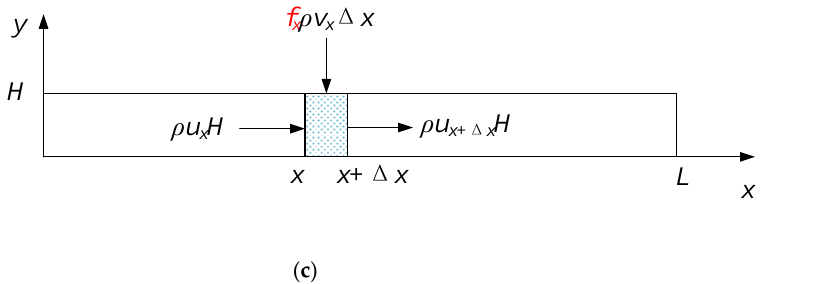
Figure 2. Schematic diagram of a single channel. ( a ) 3-D diagram; ( b ) Diagram for basic outflow model; ( c ) Diagram for the extended model.